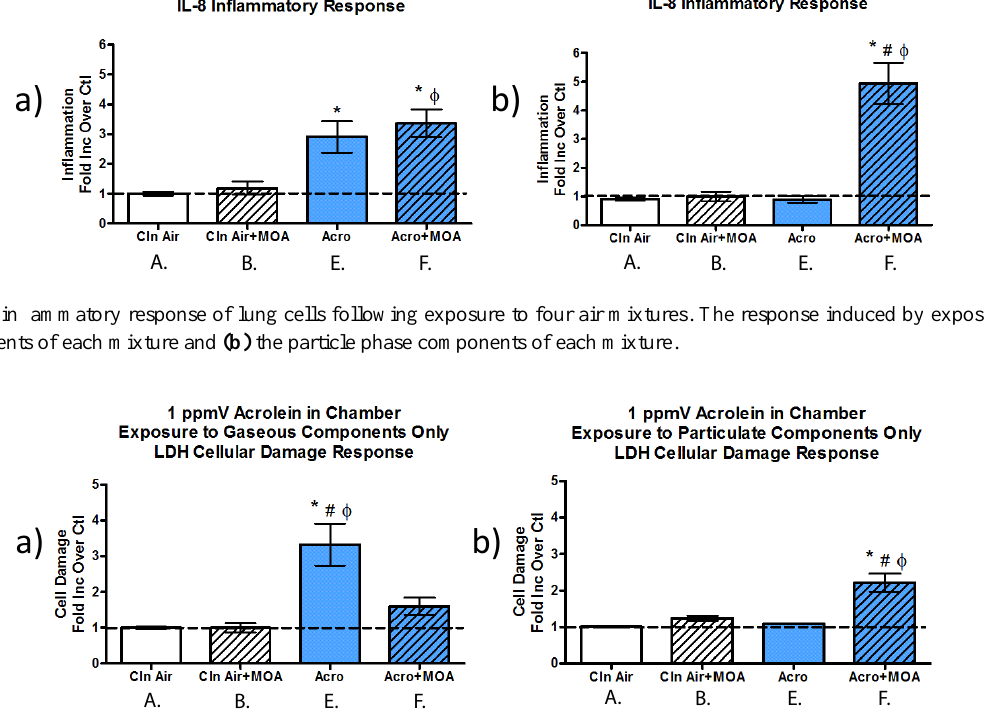
Fig. 7. Cellular damage following exposure to four air mixtures. The response induced by exposure to (a) the gaseous components of each mixture and (b) the particle-phase components of each